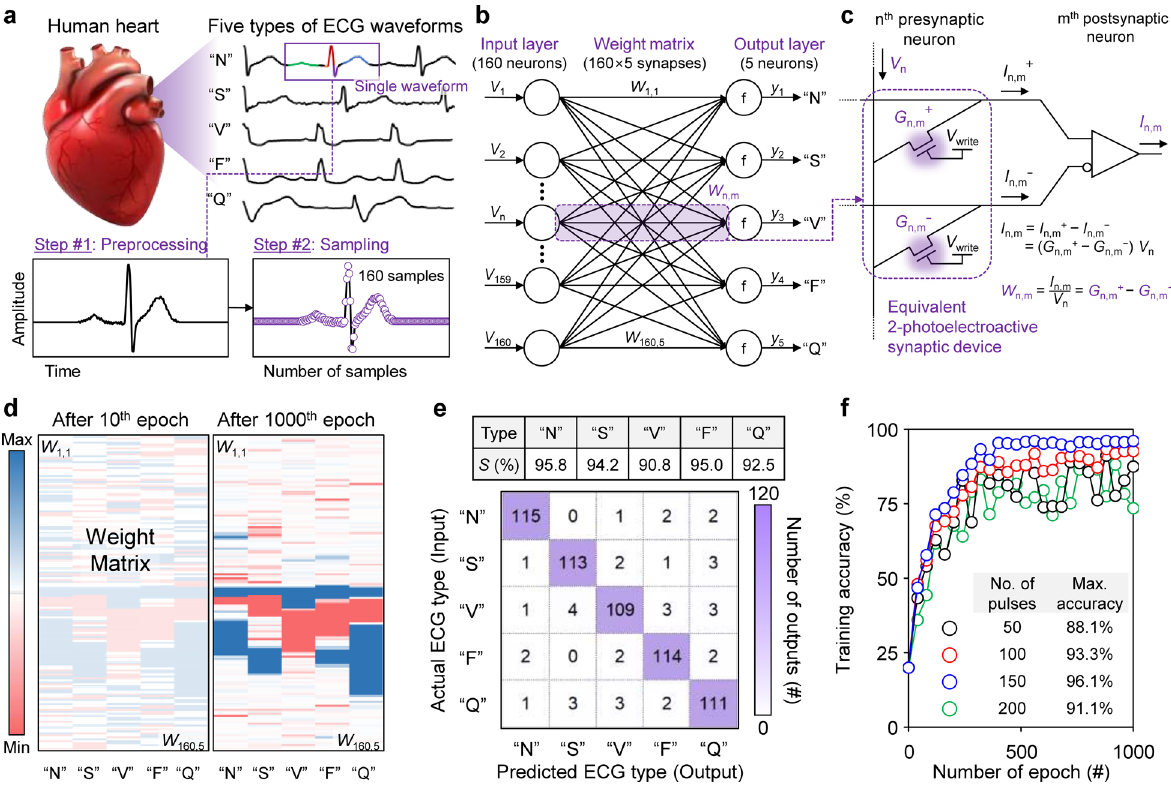
Fig. 4 Electrocardiogram pattern training and inference task. a Five types of electrocardiogram (ECG) waveforms and preparation process for training and testing datasets. b Schematic illustration of the designed single-layer neural network with a size of 160 × 5. c Representation of synaptic weight using the conductance difference between two equivalent photoelectroactive synaptic devices. d Mapping images of 800 synaptic weights after 10th and 1000th epochs. e Confusion matrix of heartbeat type classi fi cation for 600 test datasets. f Training accuracy as a function of the number of training epochs according to the number of